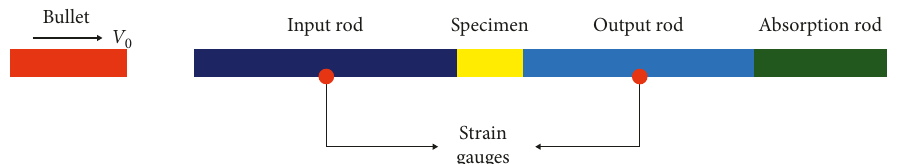
Figure 5: Split-Hopkinson pressure bar